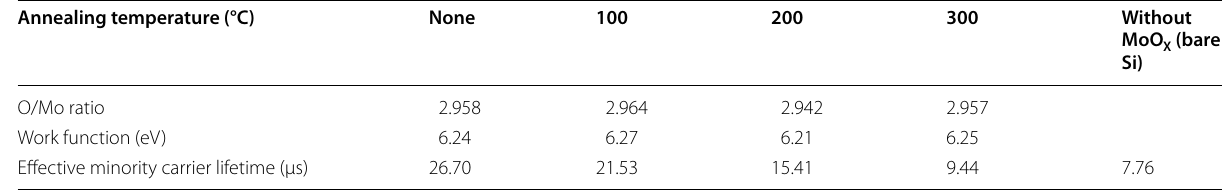
films on silicon wafers. Effective minority carrier X films X